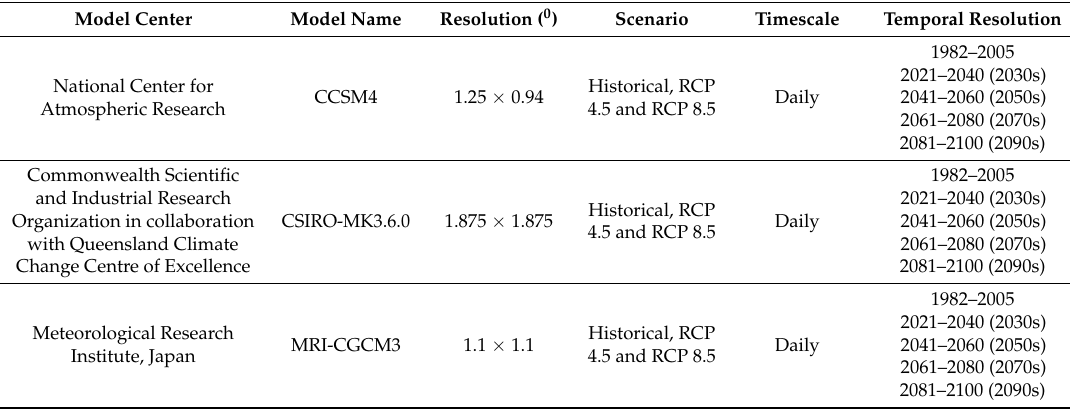
Table 3. Details of the climate models used to downscale future precipitation for this